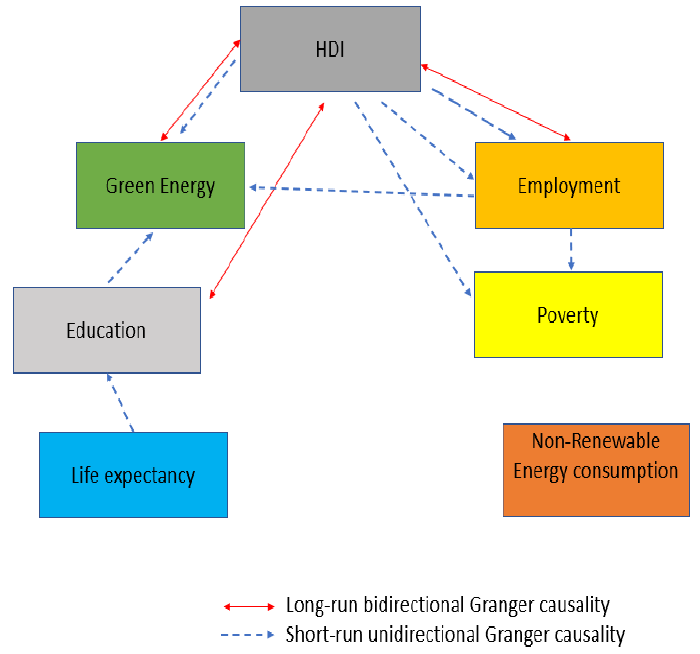
Figure 4. The causality relationship of the studied variables.